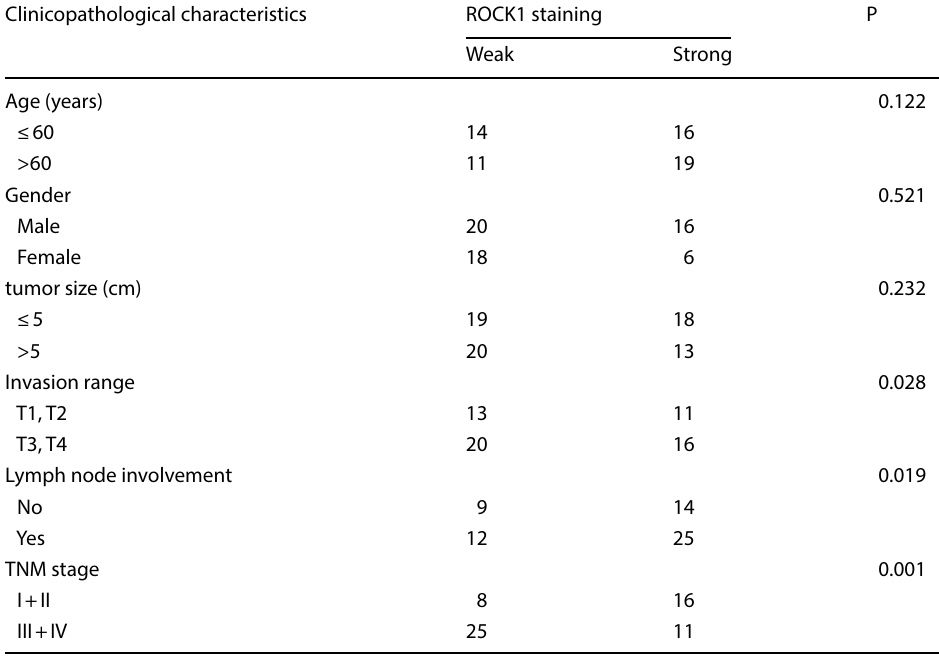
Table 1 Relationship between ROCK1 expression level and clinicopathological characteristics in 60 LSCC